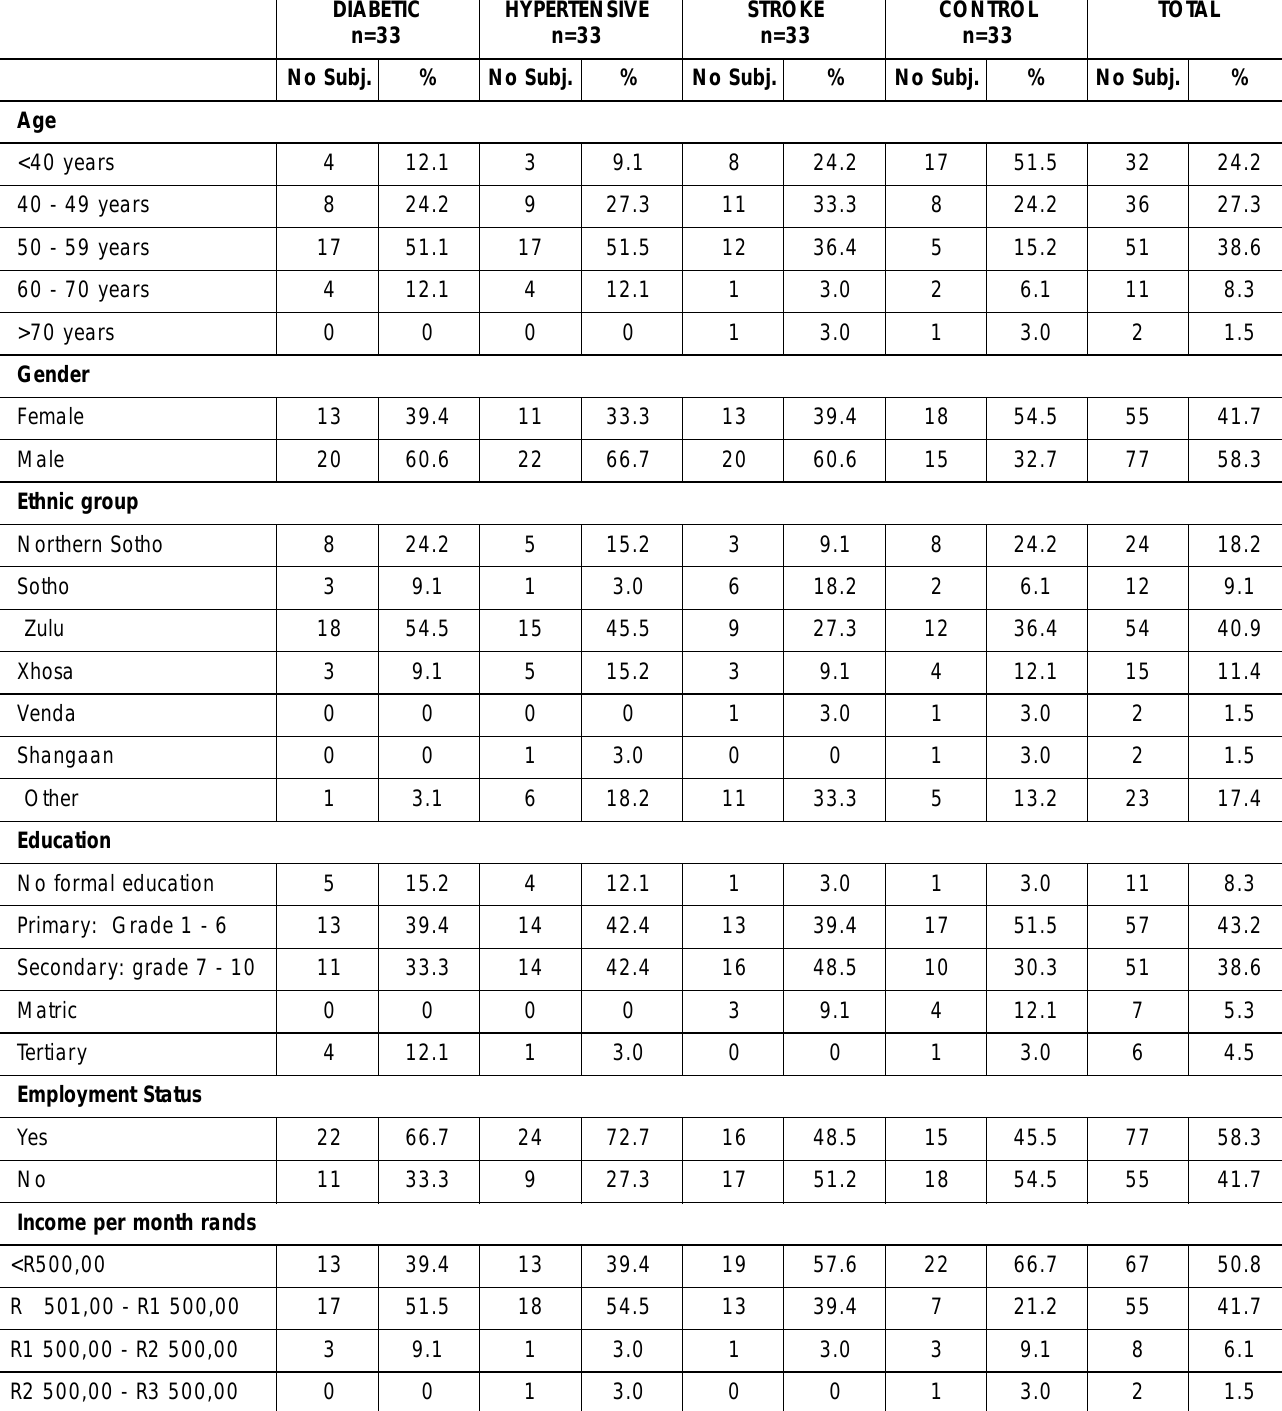
Table 1: Distribution of demographic characteristics for groups.